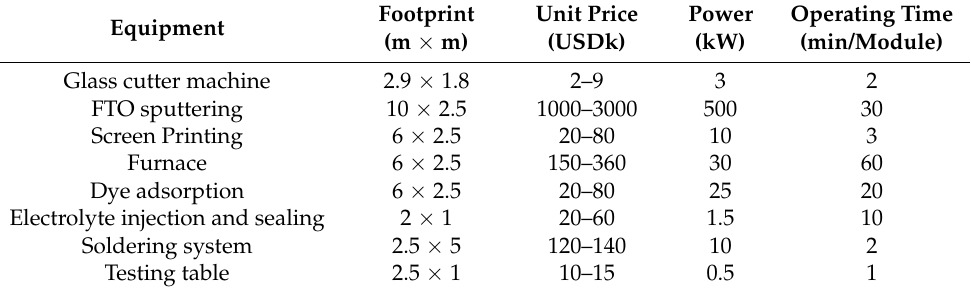
Table 2. Equipment costs.